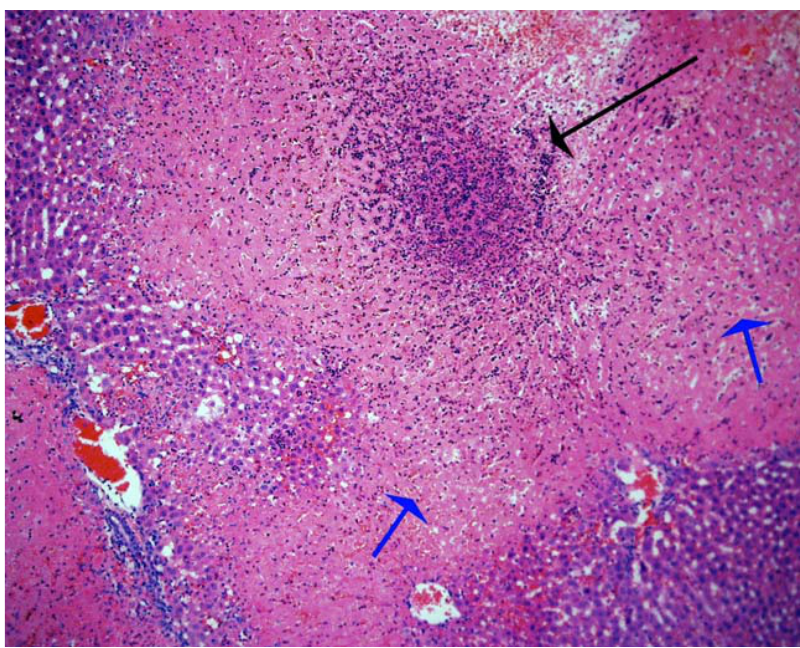
FIGURA 3 – Corte histológico do fígado de coelho decorridas 24 horas da injeção de solução de ácido acetilsalicílico 5%. Área